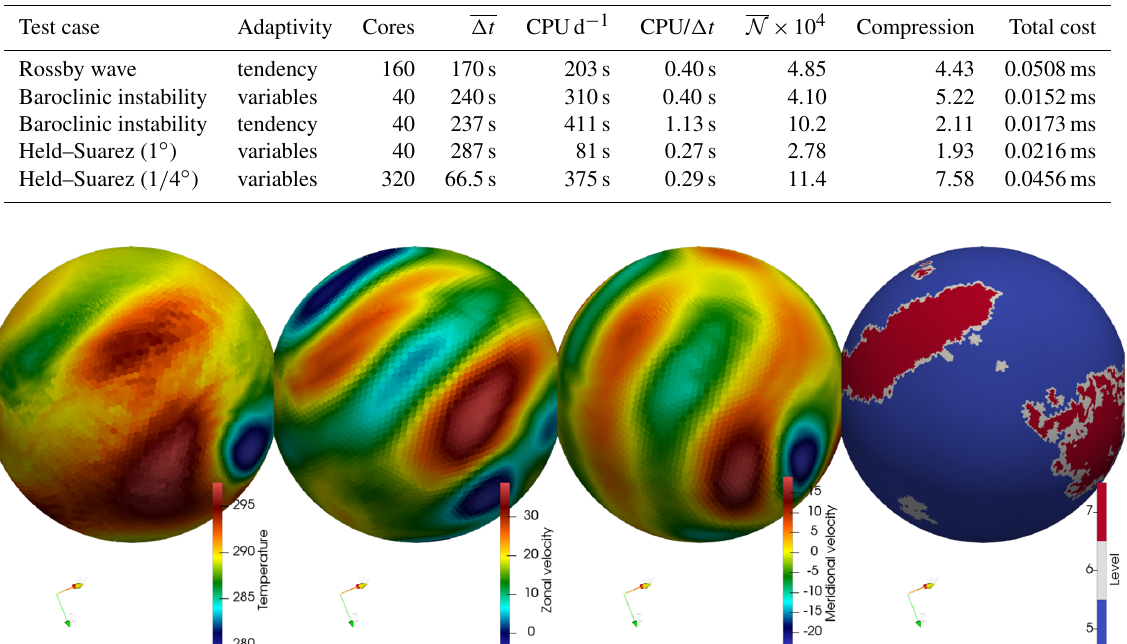
Figure 6. Results of the adaptive simulation of the mountain-induced Rossby wave case shown at 700hPa at day